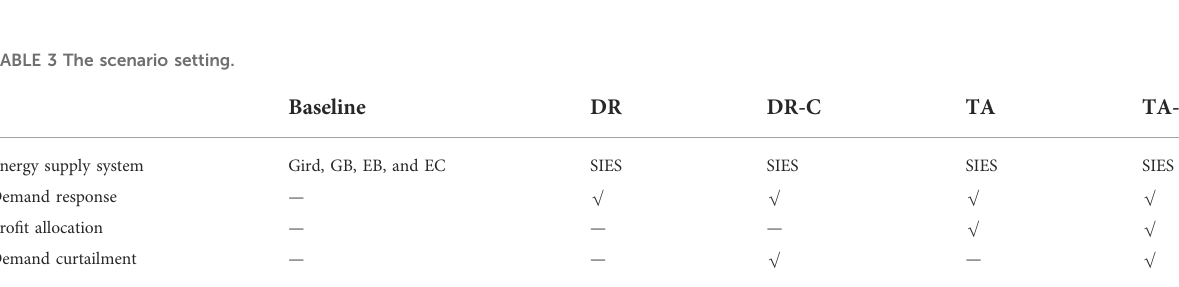
TABLE 3 The scenario